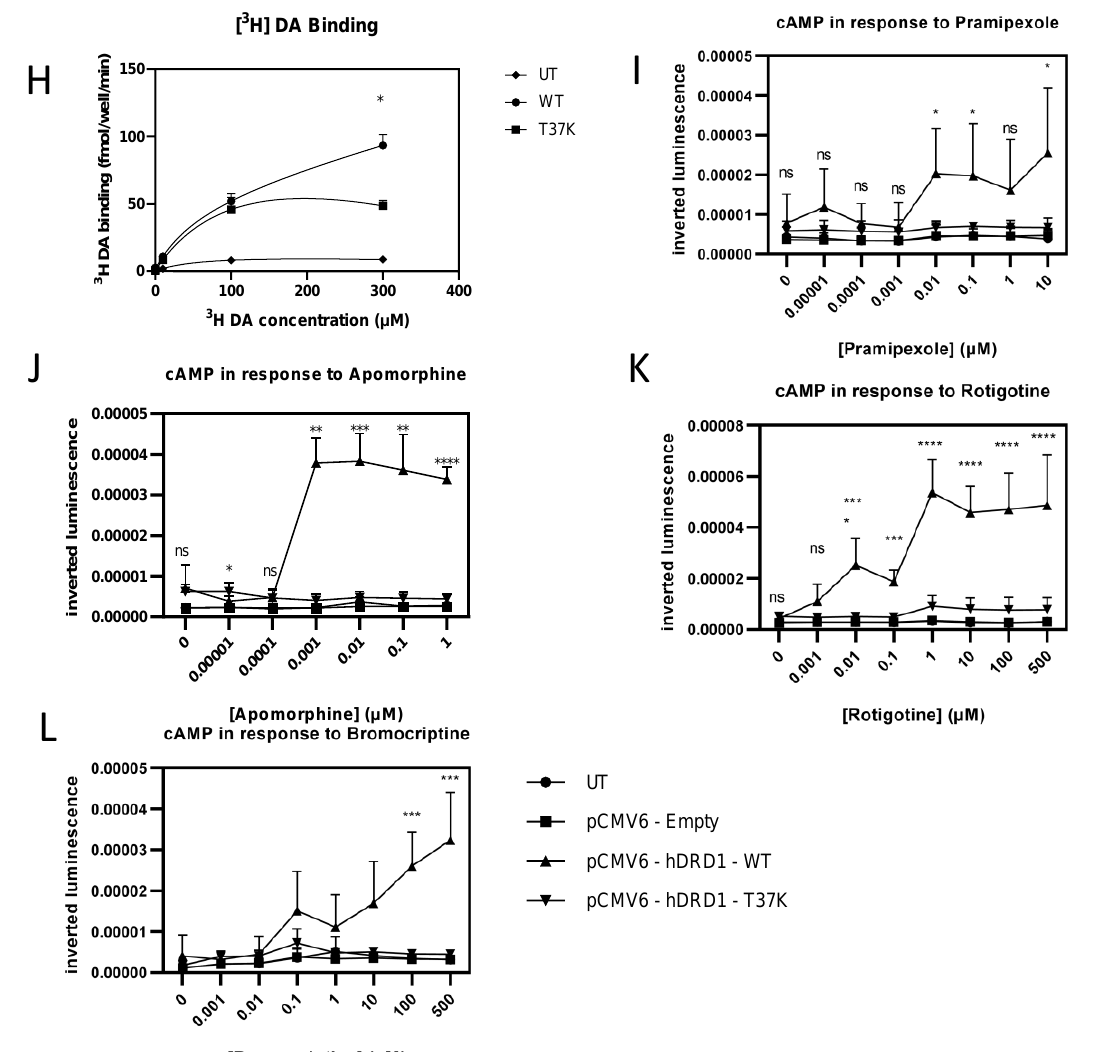
Figure 4. Effect of T37K variant on cAMP production and ligand binding. ( A ) HEK-293T cells transfected with either DRD1 -WT or DRD1 -T37K were treated with increasing concentrations of Chloro APB for 10 min and cAMP levels recorded. Graph displays the mean inverted luminescence +/ − SEM (n = 6). ns = not significant, * p < 0.05, ** p < 0.01, *** p < 0.005, **** p < 0.001 (2-way ANOVA between DRD1 -WT and DRD1 -T37K). ( B – G ) Structures of DRD1 wildtype and modelled T37K mutant proteins. The side view of the DRD1 proteins showing the angles between the helices TM1 and TM2 with the wildtype protein (PDB ID: 7JVP) in pink ( B ) and T37K mutant in blue ( C ). The orientation of T37 ( D ) and K37 ( E ) in the DRD1 wildtype (pink) and T37K mutant proteins (blue). The amino acids are represented in single letter codes and coloured by atom-type. Coulombic potential-based surface rendering of the wildtype ( F ) and the T37K mutant ( G ) proteins around the sites depicted in ( C , D ). Red, blue and white correspond to negative, positive and no charge on the residues, respectively. The graphical representation of the protein structures was created using the molecular graphics program Chimera (http://www.cgl.ucsf.edu/chimera/ accessed on 1 December 2022). ( H ) DA binding to either D 1 -WT or D 1 -T37K was investigated using increasing concentrations of ( 3 H) DA. Data are presented as the mean +/ − SEM relative to untransfected treated cells (2-way ANOVA, n = 6, p < 0.05). ( I – L ) Transfected HEK-293T cells treated with clinically relevant D 1